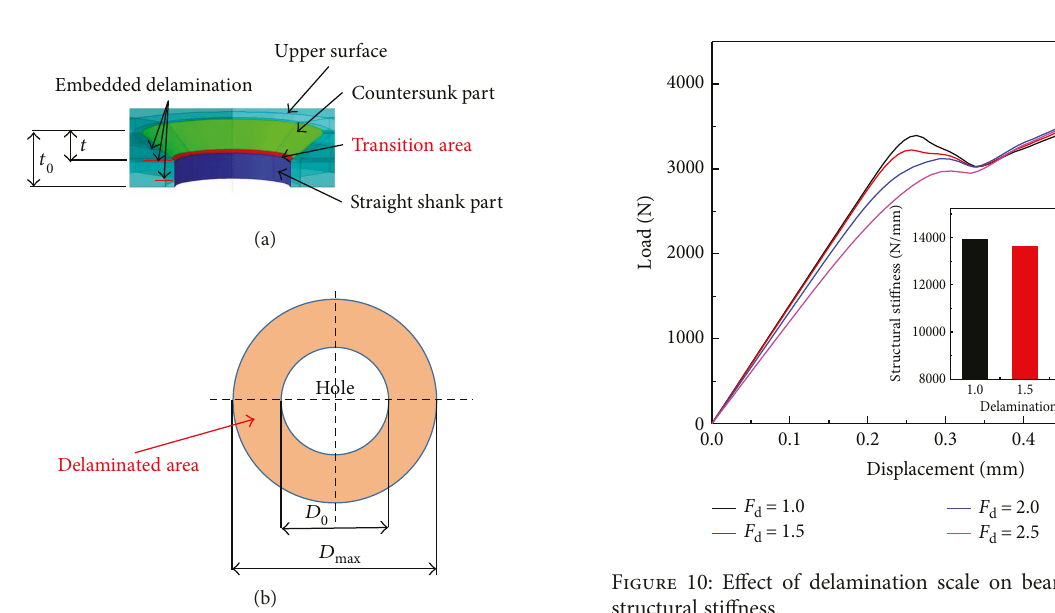
Figure 8: Process of delamination propagation: damage initiation, damage evolution, and structural failure.